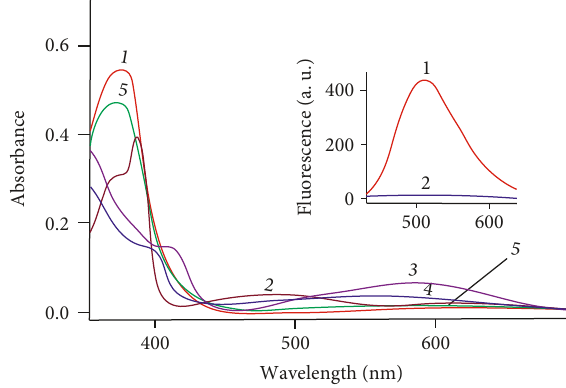
Figure 3: Electronic absorption spectra of 4 in acetonitrile ( 2 0 · 10 − 5 M ) before ( 1 ) and after addition of metal cations (in the form of perchlorates) Zn 2+ ( 2 ), Ni 2+ ( 3 ), Hg 2+ ( 4 ), and Со 2+ ( 5 ) ( 2 0 · 10 − 4 M ); inset: fl uorescence before ( 1 ) and after addition of Hg 2+ ( 2